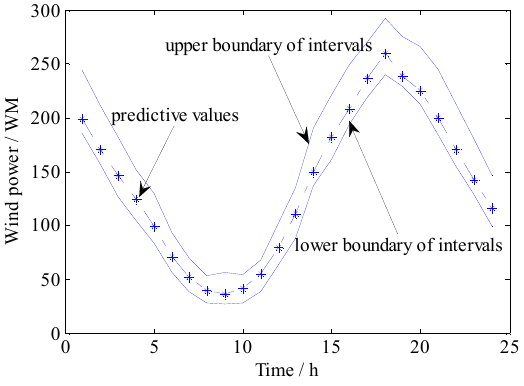
Figure 10. The optimal wind power confidence intervals (Case 3).